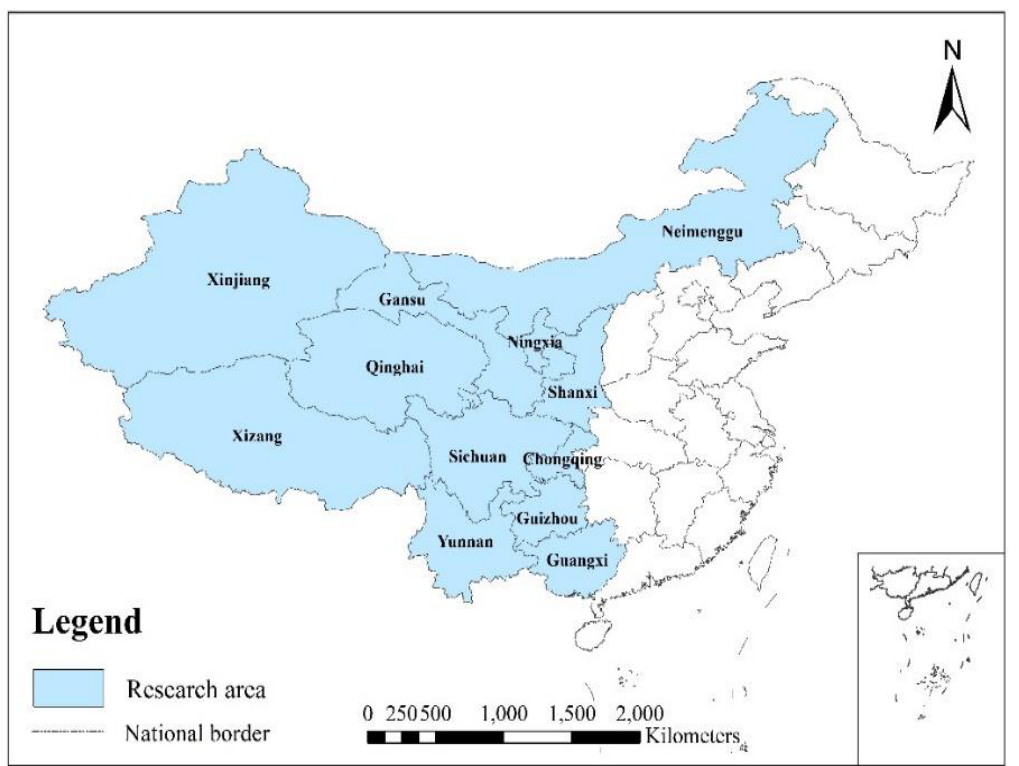
Figure 1. Study Area.